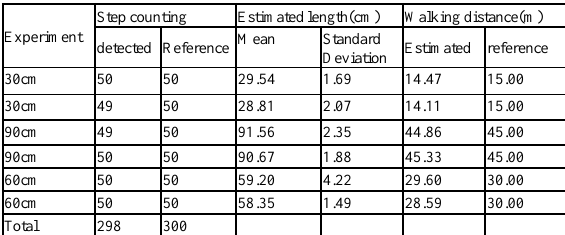
Table 3. The experiment results of step length estimation